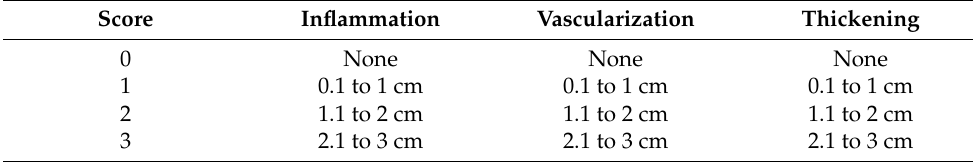
Table 3. Macroscopic observations scoring of the ileum and colon of mice. Score Inflammation Vascularization Thickening 0 None None